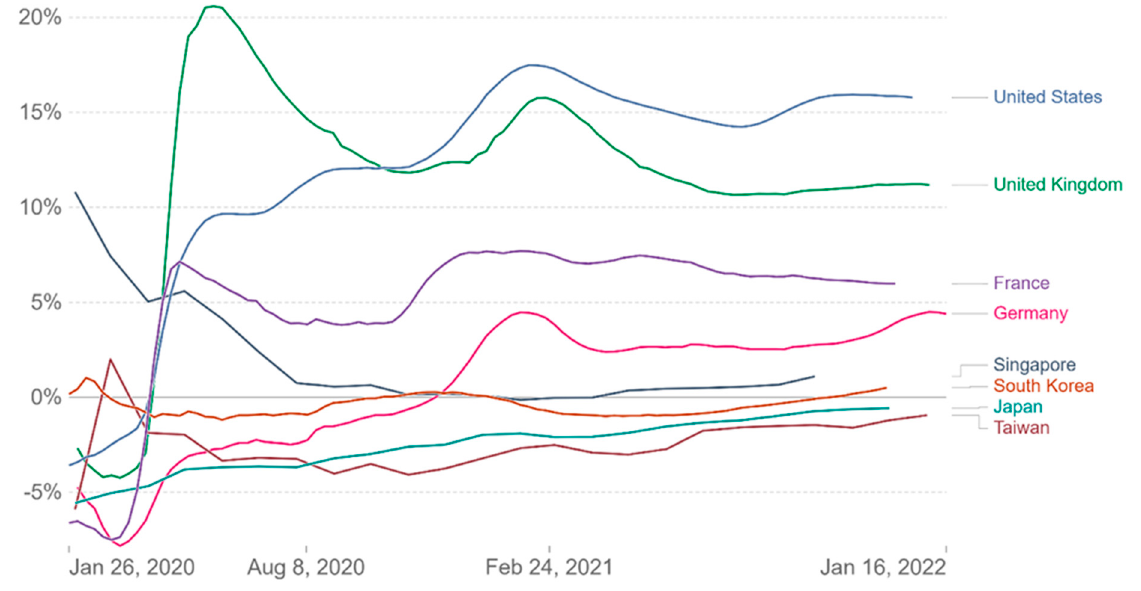
Figure 2. Excess mortality rates in developed and middle power countries. Source: Data from Human Mortality Database (2022), World Mortality Dataset (2022) via Our World in Data (https://ourworldindata.org (accessed on 9 January 2022)) (Karlinsky and Kobak 2021).